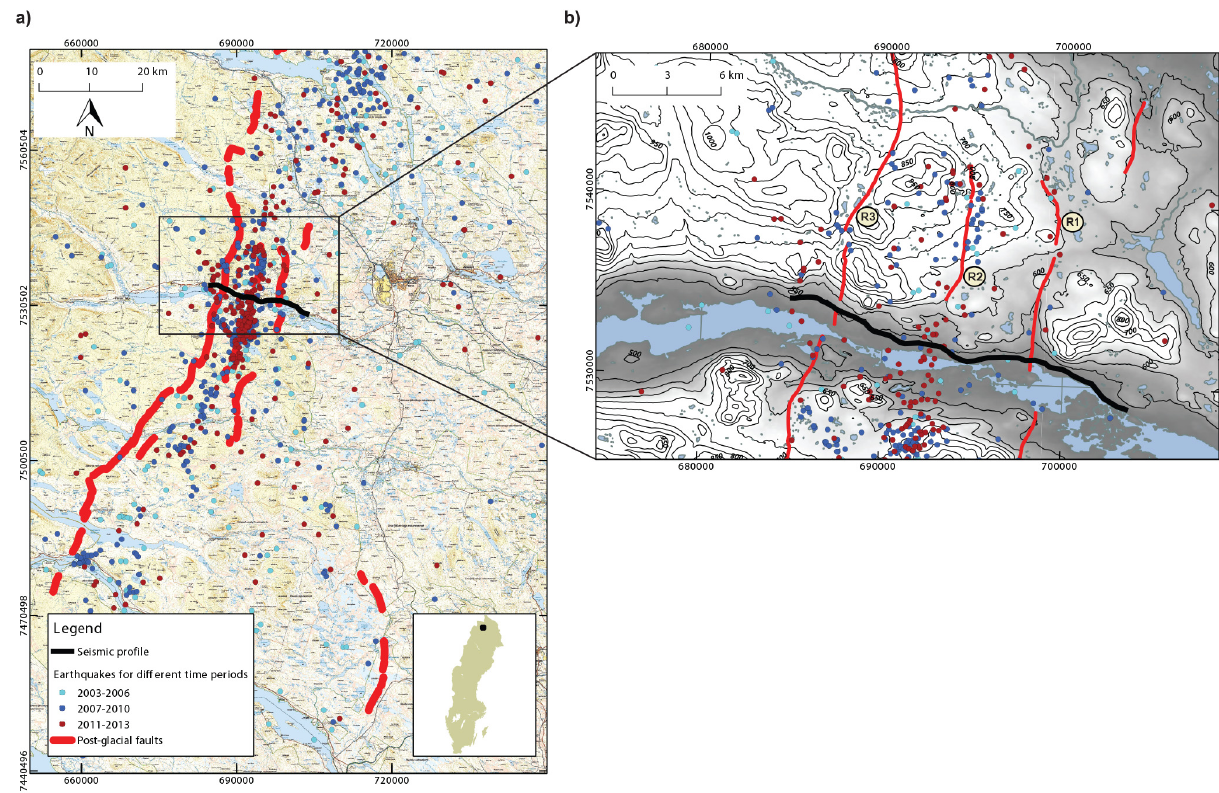
Figure 1. Location of the seismic profile over the Pärvie fault system in northern Sweden. Earthquakes are shown for three different time periods (after Lindblom et al., 2015). Inset shows the location of the Pärvie area in northern Sweden. (b) The end-glacial Pärvie faults overlaid on a topographic map. © Lantmäteriet